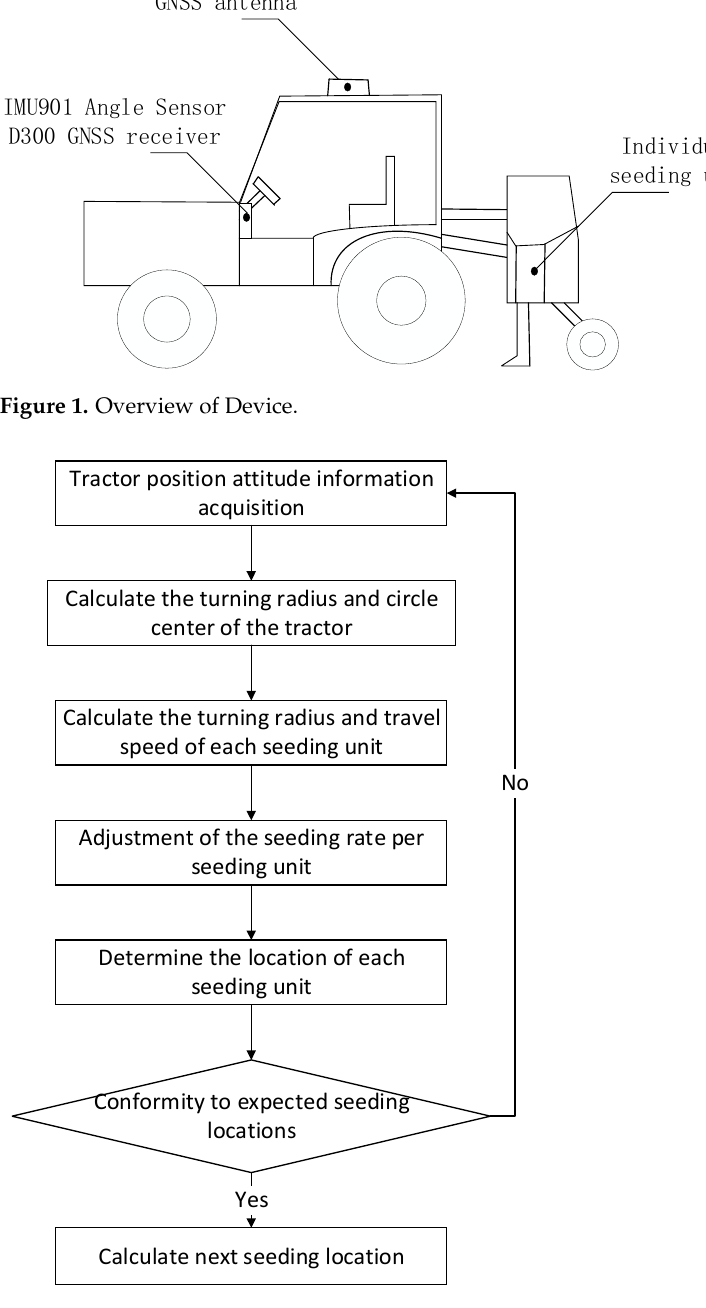
Figure 2. Algorithm Flow Chart.